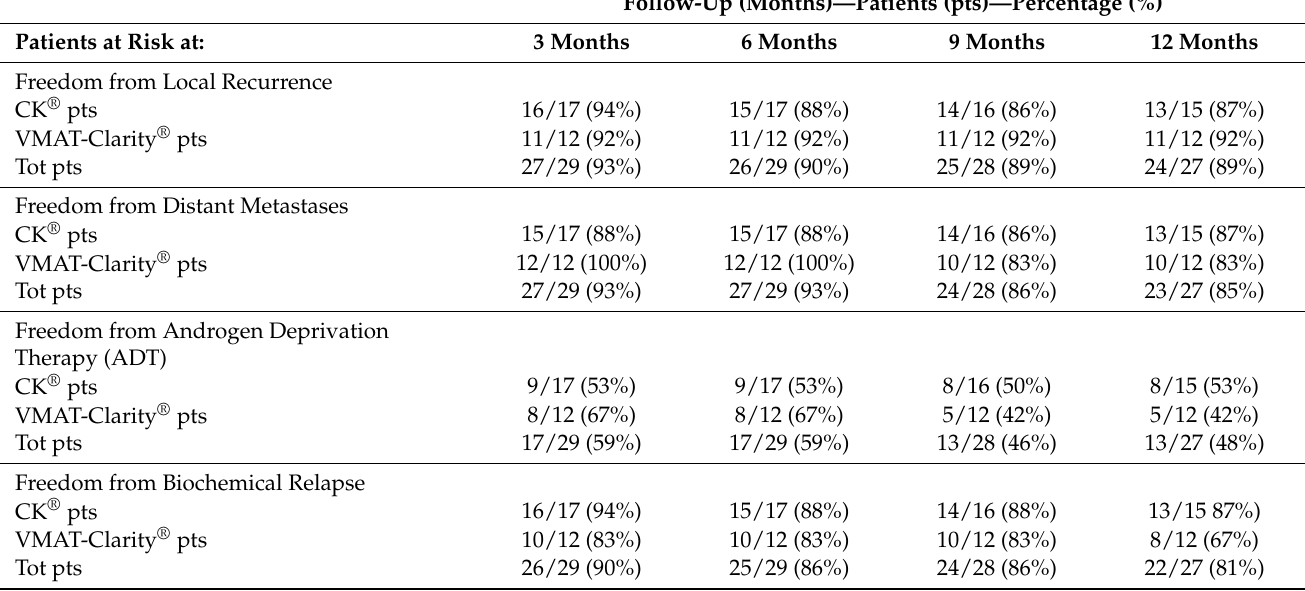
Table 4. Outcomes of